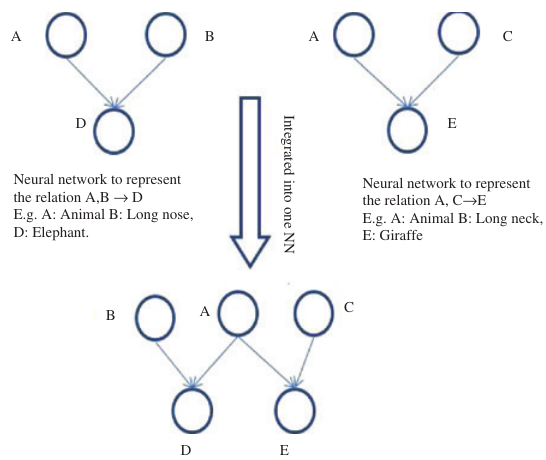
Figure 2: Illustrating the Problem of ANN to Represent Logical